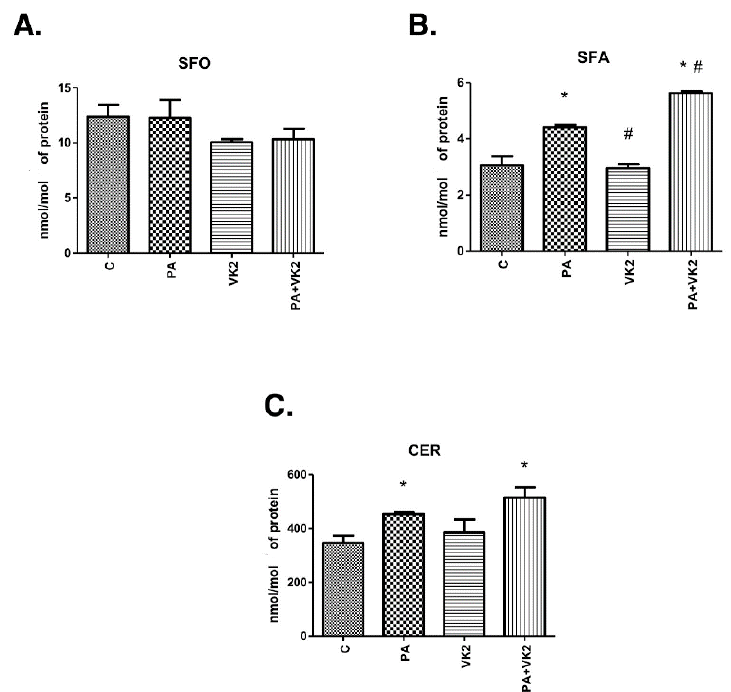
Figure 1. Intracellular concentration of sphingosine (SFO) ( A ), sphinganine (SFA) ( B ) and ceramide (CER) ( C ) in HepG2 cells. The cells were incubated for 16 h with palmitic acid and/or vitamin K2. The sphingolipids concentration was measured by high-performance liquid chromatography as described in the Materials and Methods section. The results are presented as mean ± SD and are based on six independent determinations. *– P < 0.05 significant difference vs control group, #– P < 0.05 significant difference vs palmitate group; C–control, PA–palmitate, VK2–vitamin K2, PA + VK2–palmitate and vitamin K2.